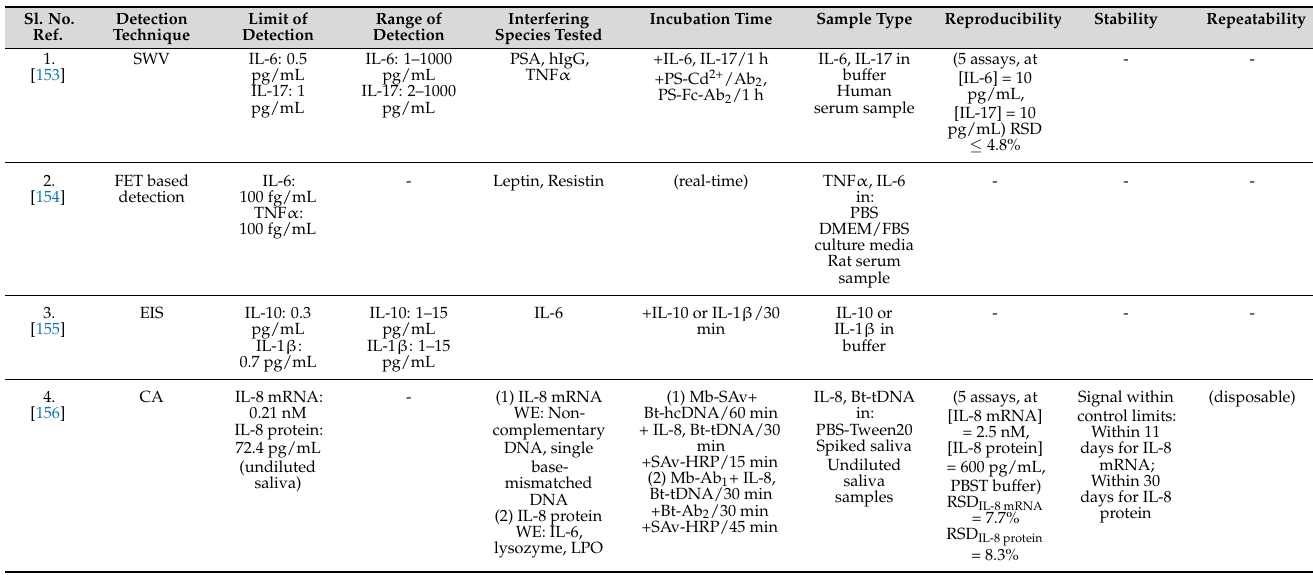
Table 18. Biosensors for multiplexed cytokine detection: Specifications and performance characteristics. Sl. No.